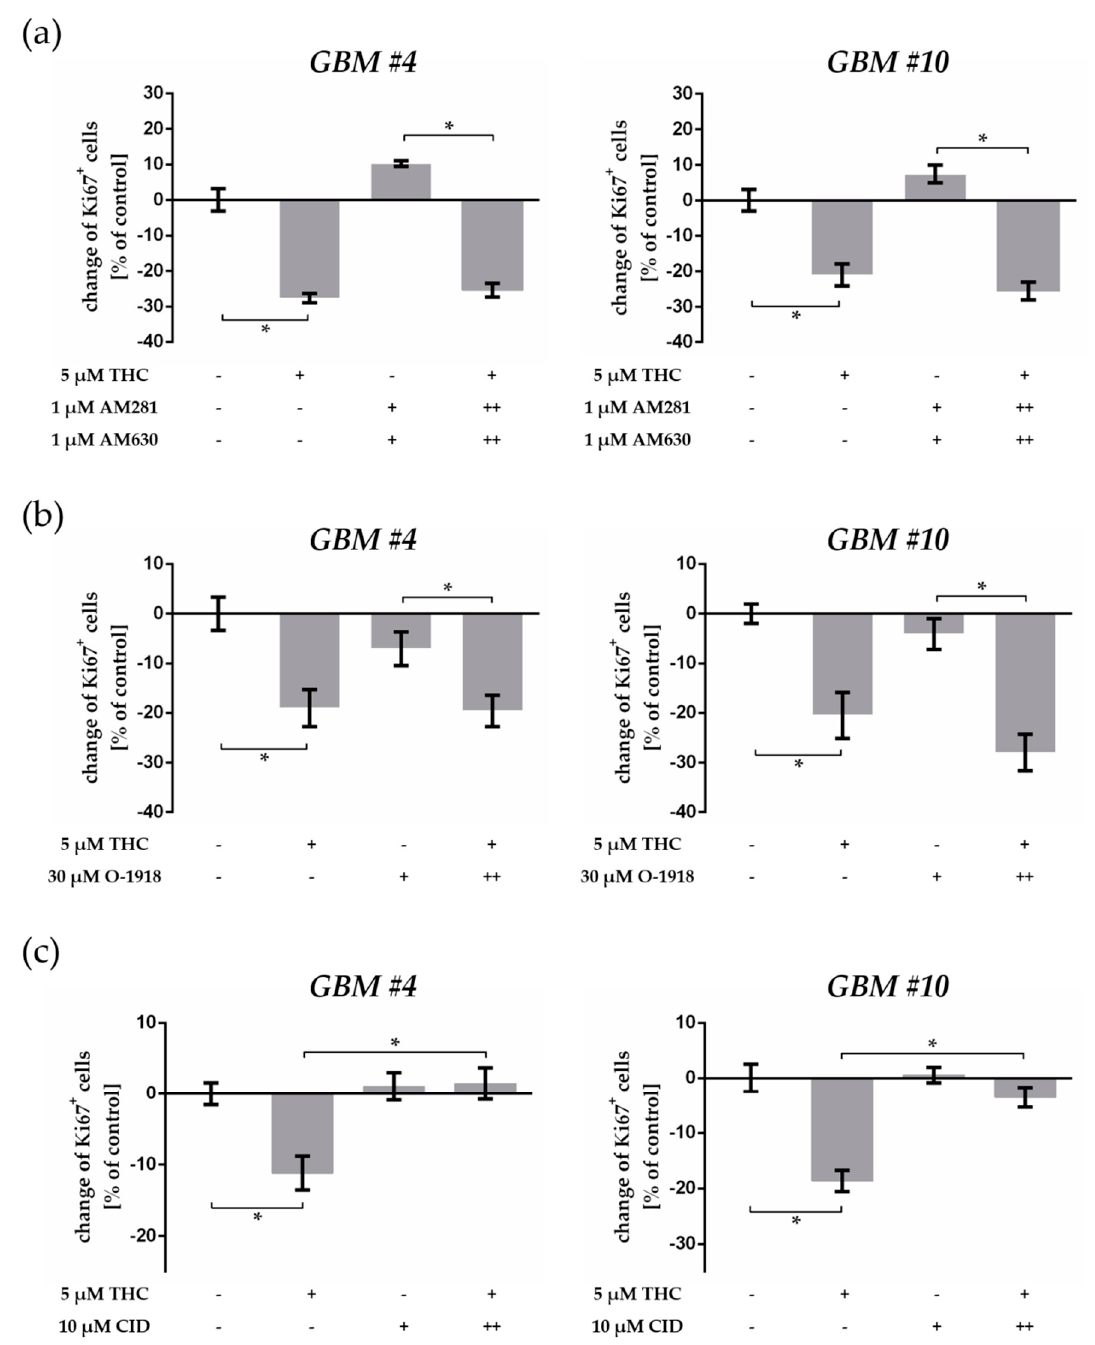
Figure 4. Impact of receptor-specific antagonists on THC-triggered effects. ( a ) Impact of CB 1 - and CB 2 -antagonists AM281 and AM630 on THC effects. AM281 (1 µ M) and AM630 (1 µ M) combined with THC (5 µ M) had no effects on the decreased number of Ki67 + cells by THC. Co-stimulation with AM281 and AM630 alone did not influence the percentage of Ki67 + cells in G BM #4 and GBM #10 after 24 h compared to the control group. ( b ) Impact of GPR18 antagonist O-1918 on THC effects. After inhibition of GPR18 by O-1918 (30 µ M) responses to THC (5 µ M) remained unaffected. Administration of O-1918 alone had no influences. ( c ) Impact of GPR55 antagonist CID16020046 (CID) on THC effects. The Ki67-reducing effects of THC (5 µ M) were effectively attenuated when CID (10 µ M) was co-applied, whereas CID alone induced no alterations in the number of Ki67-immunoreactive nuclei in comparison to the untreated control group. To block each receptor, we applied the corresponding antagonist 15 min (++) before THC was subsequently added. Data are means ± SEM of N = 3 independent experiments performed in duplicate. Significance was chosen for p < 0.05. The asterisk denotes significant results regarding the respective measurement indicated with the bar.